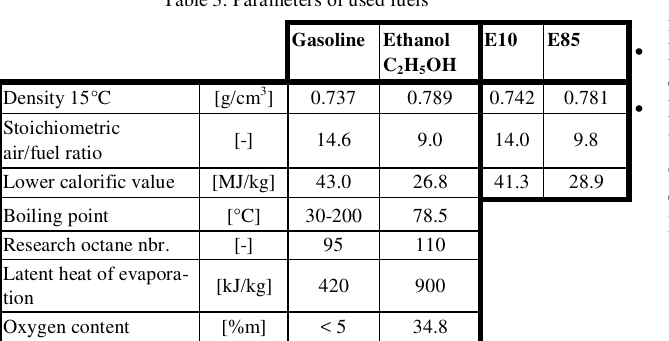
Table 3. Parameters of used fuels